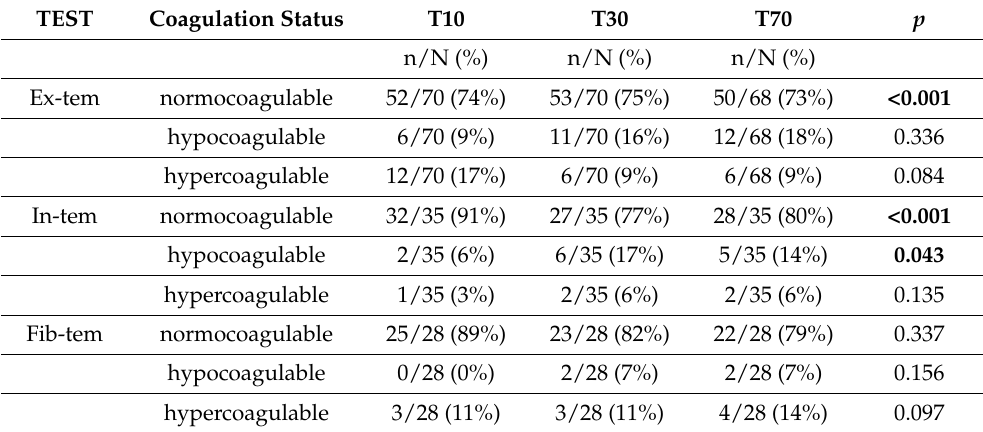
Table 5. Coagulation status over